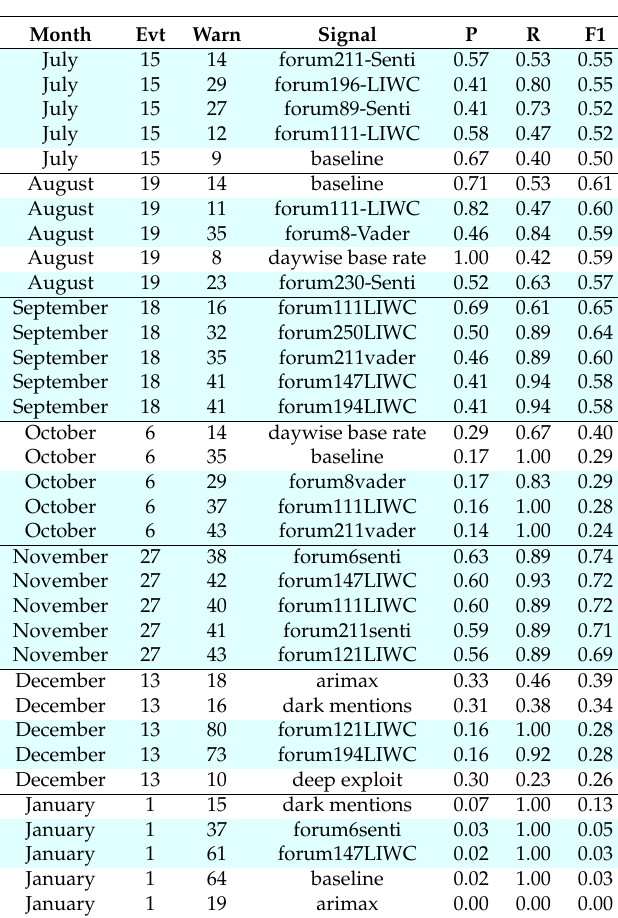
Table A1. Results from Organization A’s endpoint